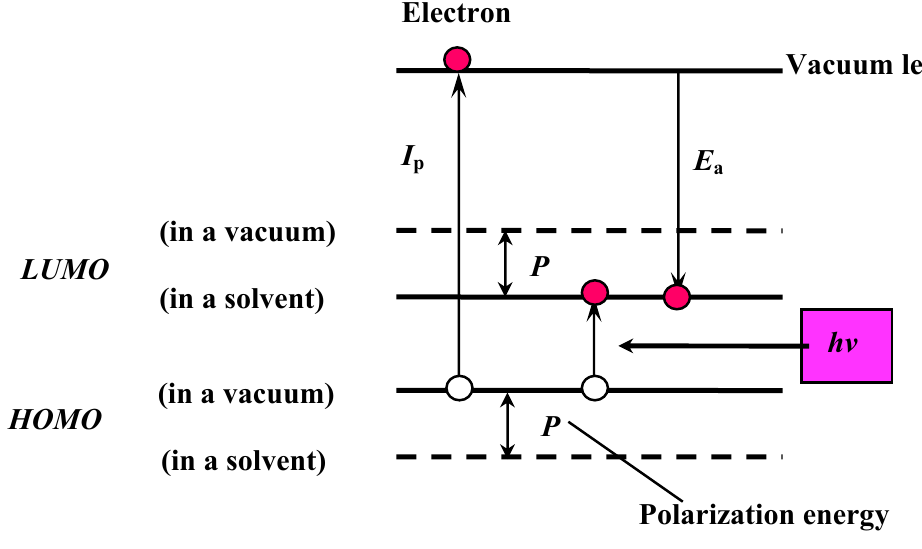
Figure 4. The correlation of molecular energy levels between in a vacuum and in a